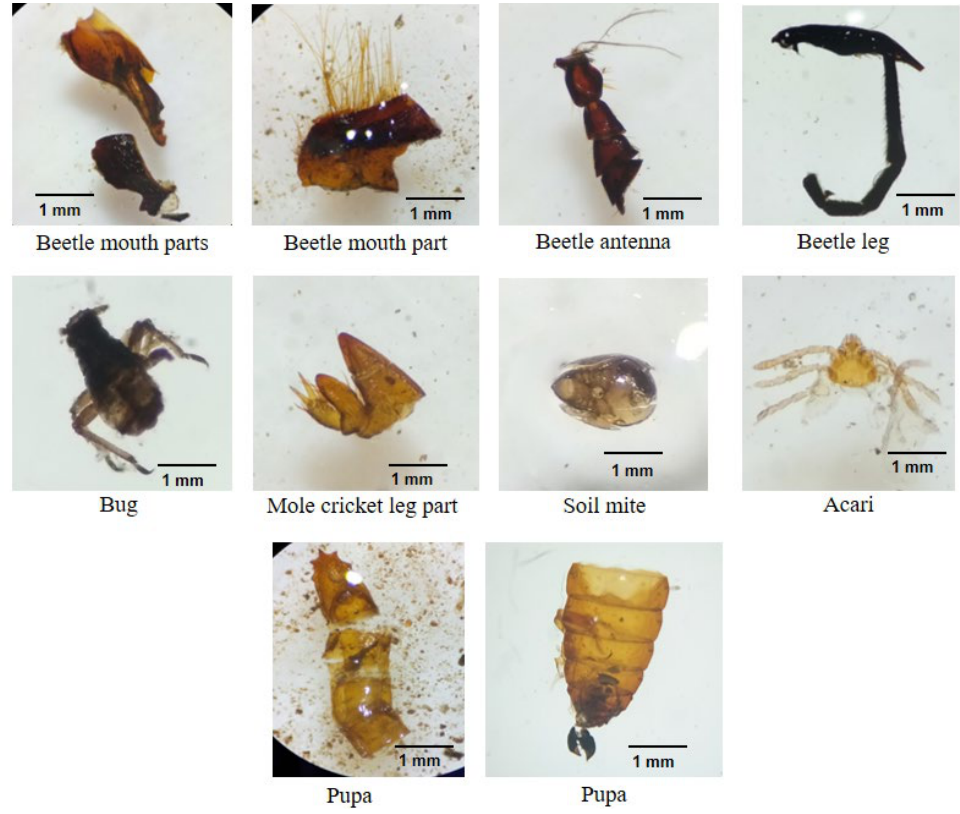
Figure 8. Insect body remains from fecal samples of Chinese pangolins in Chandragiri Municipality, Nepal.